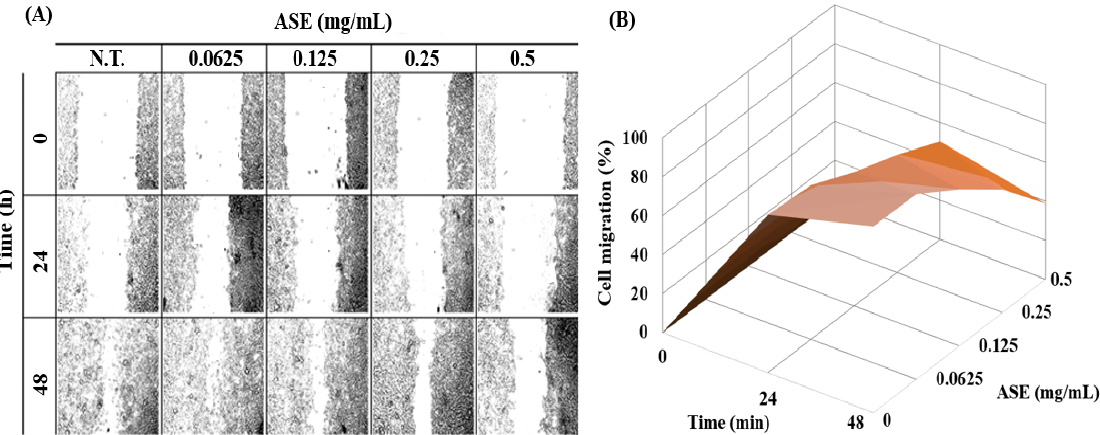
Figure 2. Effect of ASE on the B16-F0 cell migration. Migration rates were quantitatively analyzed by calculating the difference between wound area of ASE-treated and control groups at 0, 24, and 48 h. Results are expressed as mean ± standard deviation ( n = 3), ( A ) Images of wound-healing assays. All the images show the progress of wound closure on scratch wounded B16-F0 cells. ( B ) 3-D graph showing the effect of ASE concentration and wound healing time on B16-F0 cell